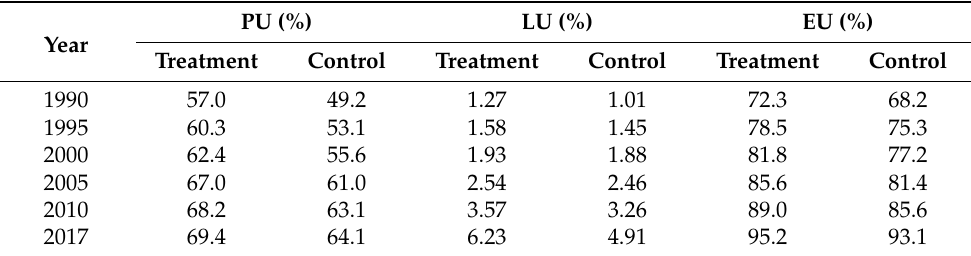
Table 2. Urbanization evolution trend of treatment group and control group. PU